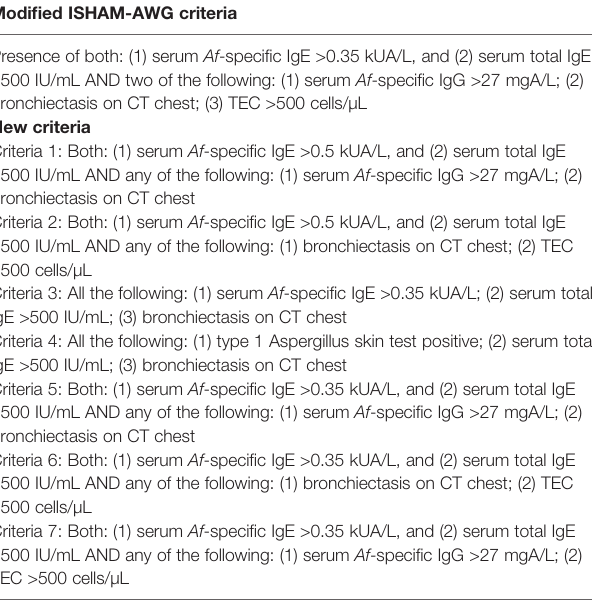
TABLE 1 | Various proposed simpler criteria for allergic bronchopulmonary aspergillosis (ABPA) evaluated in the current study. Modi fi ed ISHAM-AWG